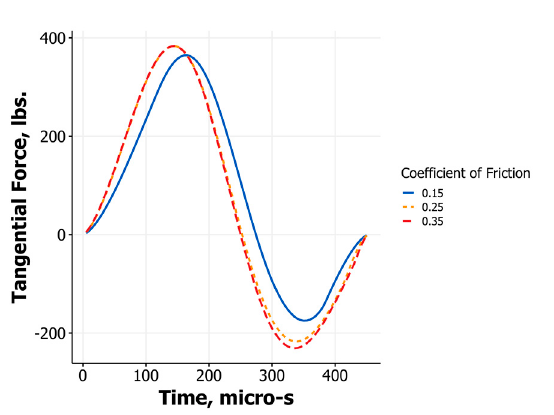
Figure 7. Tangential forces during impact as a function of time for an incident velocity of 80 mph and angle of